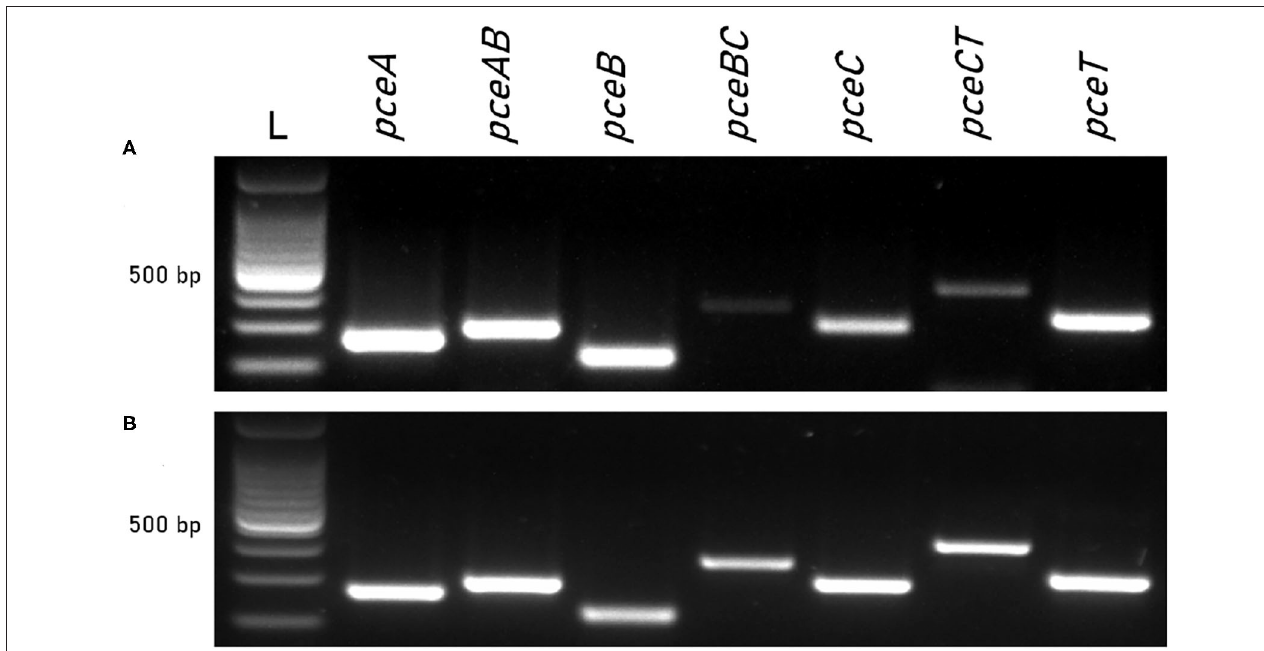
FIGURE 1 | Co-transcription of pce genes in D. restrictus and D. hafniense strain TCE1. Individual genes and gene junctions were targeted by RT-PCR on RNA from (A) D. restrictus and (B) D. hafniense strain TCE1 cultivated with H 2 and PCE as electron donor and acceptor,